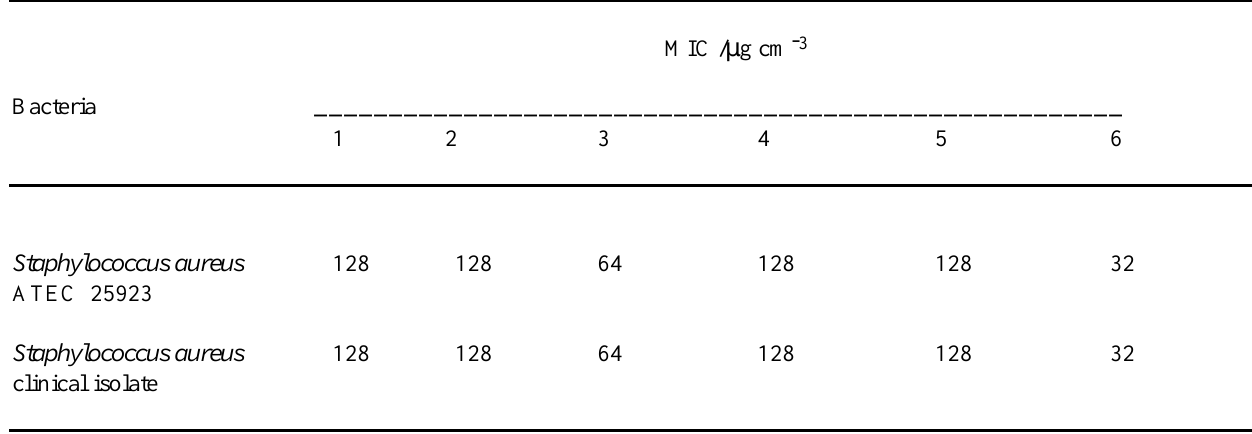
Table 2. Antibacterial activity of 2-alkenylthio-6-aminobenzothiazoles.